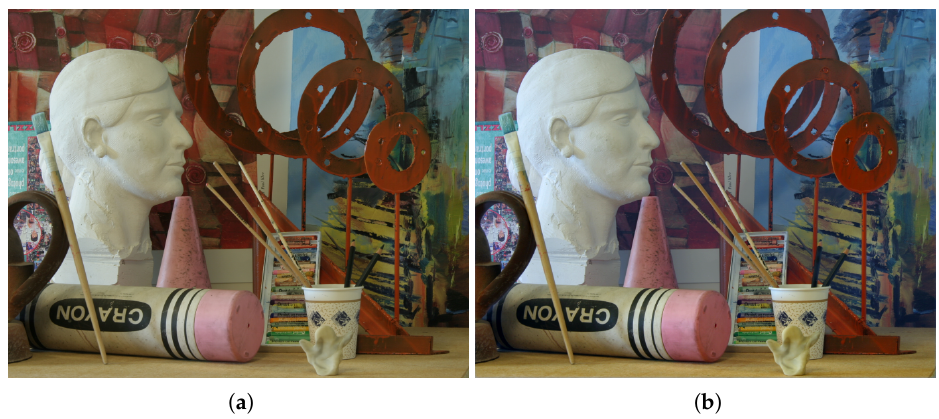
Figure 8. ( a ) The original image, which is apparently more “flat” than the processed one in ( b ). The third example gives the rendering result if the artist wants to imitate a noble yellowish gamut of old artworks and enhance the aerial perspective. Figure 10a shows the source image and Figure 10b gives the rendering result. In this test, the depth map was also constructed manually.